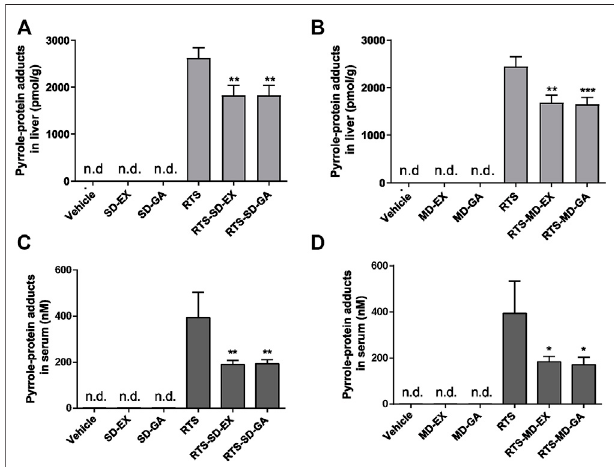
FIGURE 4 | Single-dose and multiple-dose of EX or GA inhibited metabolic activation of RTS both in vivo and in vitro . Formation of pyrrole- protein adducts in the liver (A,B) and serum (C,D) in rats. Data are expressed as mean ± SD ( n = 4). * p < 0.05, ** p < 0.01, and *** p < 0.001 versus the corresponding RTS